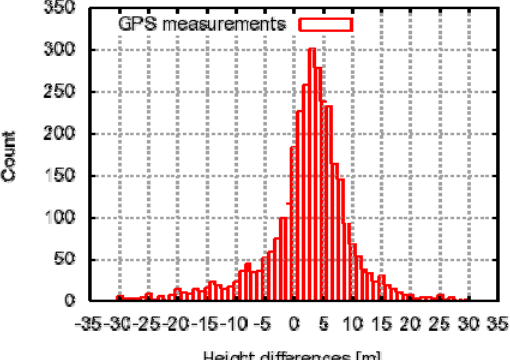
Figure 7. Comparison of heights between ground-based GPS measurements and PRISM DSM mosaic (legend is the same as that in Figure 5).